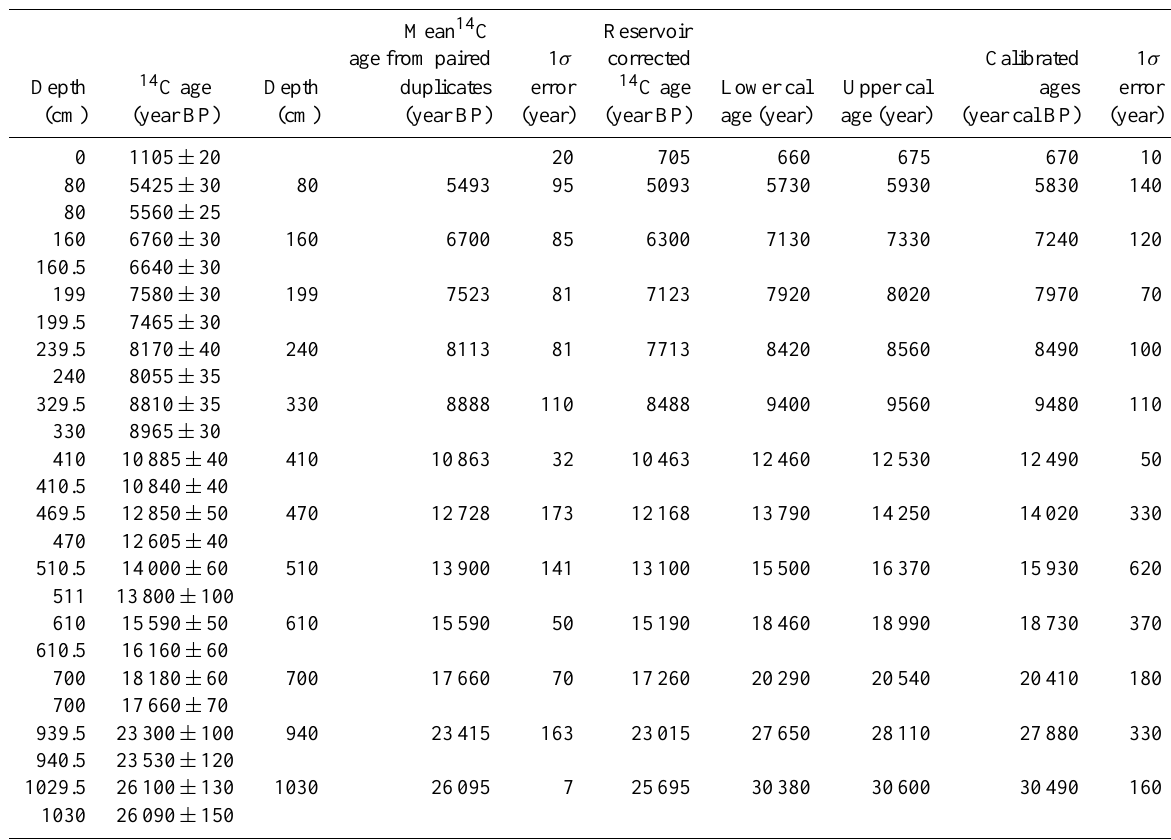
Table 1. Radiocarbon ages, corrected ages for age reservoir according to Siani et al. (2001) and calibrated ages using INTCAL 09 (Reimer et al.,